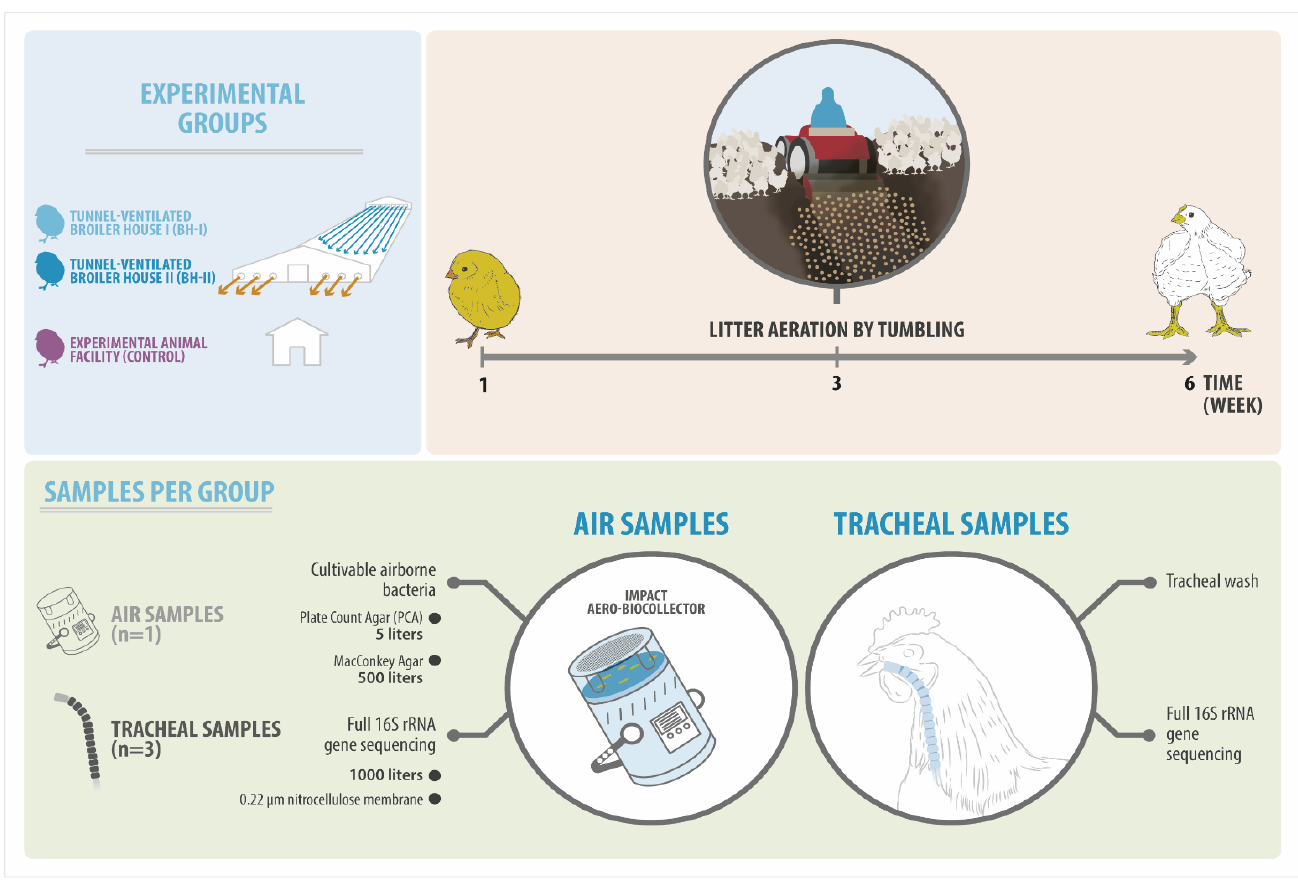
Figure 1. Experimental design of this study. Three experimental groups, including two sheds (BH-I and BH-II) and one experimental animal facility (AF), were sampled over time (week 1, 3, and 6). Air samples were taken to determine the load of cultivable bacteria and airborne bacterial diversity (16S rRNA gene). On the other hand, tracheal samples were taken to determine bacterial diversity (16S rRNA gene). It is important to highlight that in week 3, the sampling in the BH-I was performed 30 min after the litter aeration by